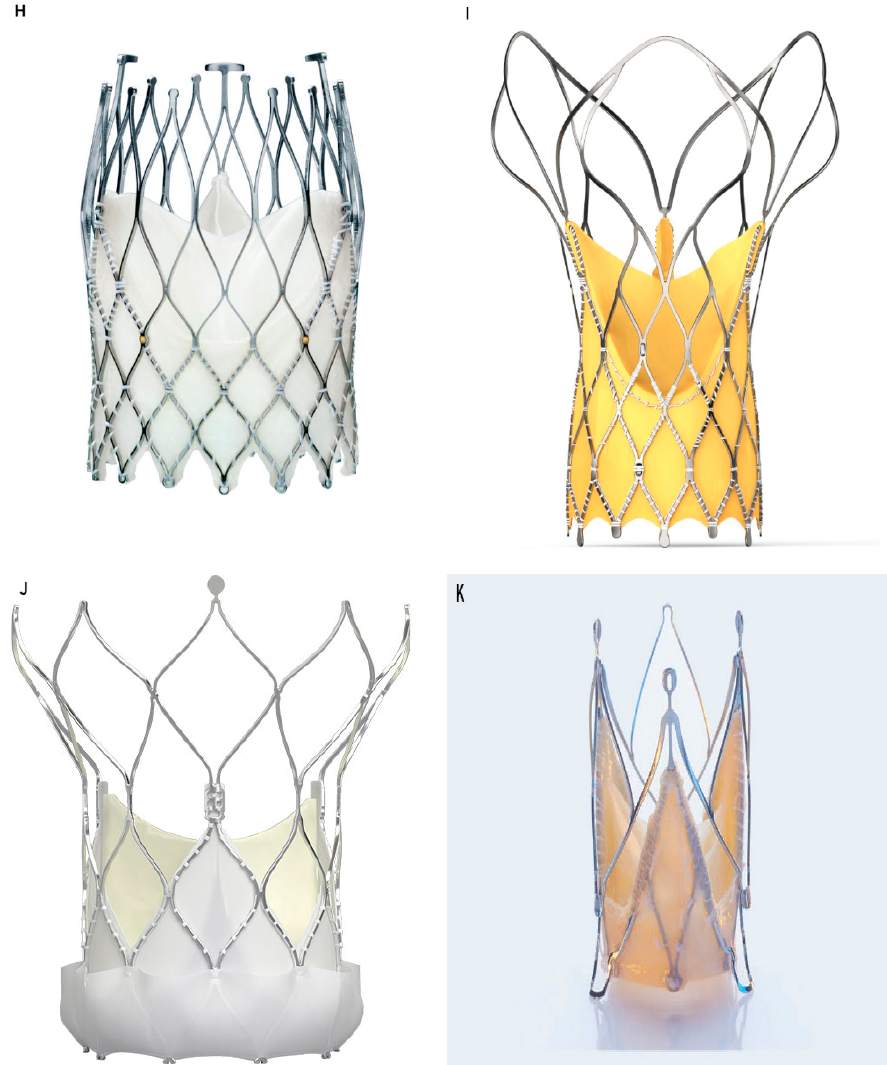
Figure 1. ( A – C ) The SAPIEN XT, SAPIEN 3 and SAPIEN 3 Ultra. Image courtesy of Edwards Lifesciences; ( D , E ) the Evolut R and Evolut R pro. Image courtesy of Medtronic; ( F , G ) the ACURATE neo and ACURATE neo2. Image courtesy of Boston Scientific; ( H ) the ALLEGRA. Image courtesy of NEW VALVE TECHNOLOGY; ( I ) the Hydra. Image courtesy of SMT; ( J ) the Navitor device, Image courtesy of Abbott; ( K ) the Jena valve, Image courtesy of JenaValve